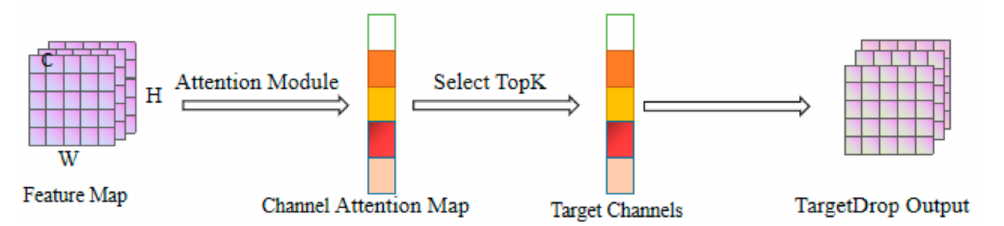
Figure 3. The pipeline of